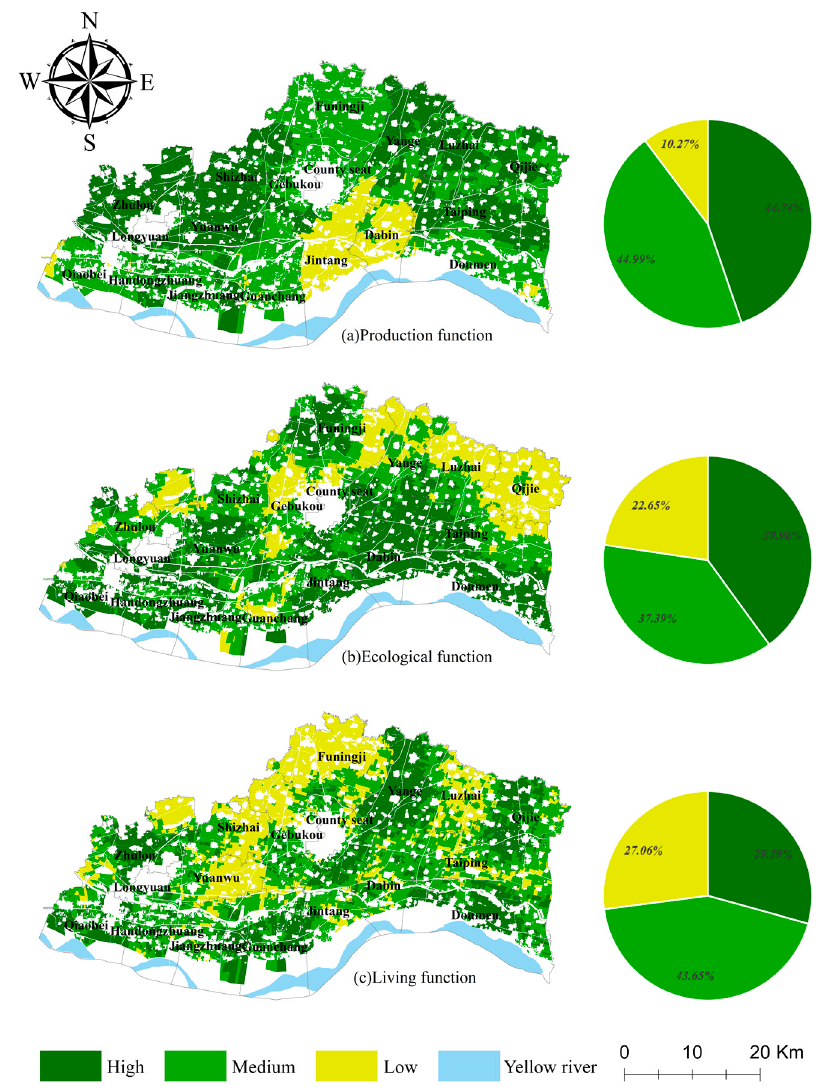
Figure 4. Results of the evaluation of individual CLUFs in Yuanyang County; ( a – c ) represent pro- duction function, ecological function, and living function, respectively.